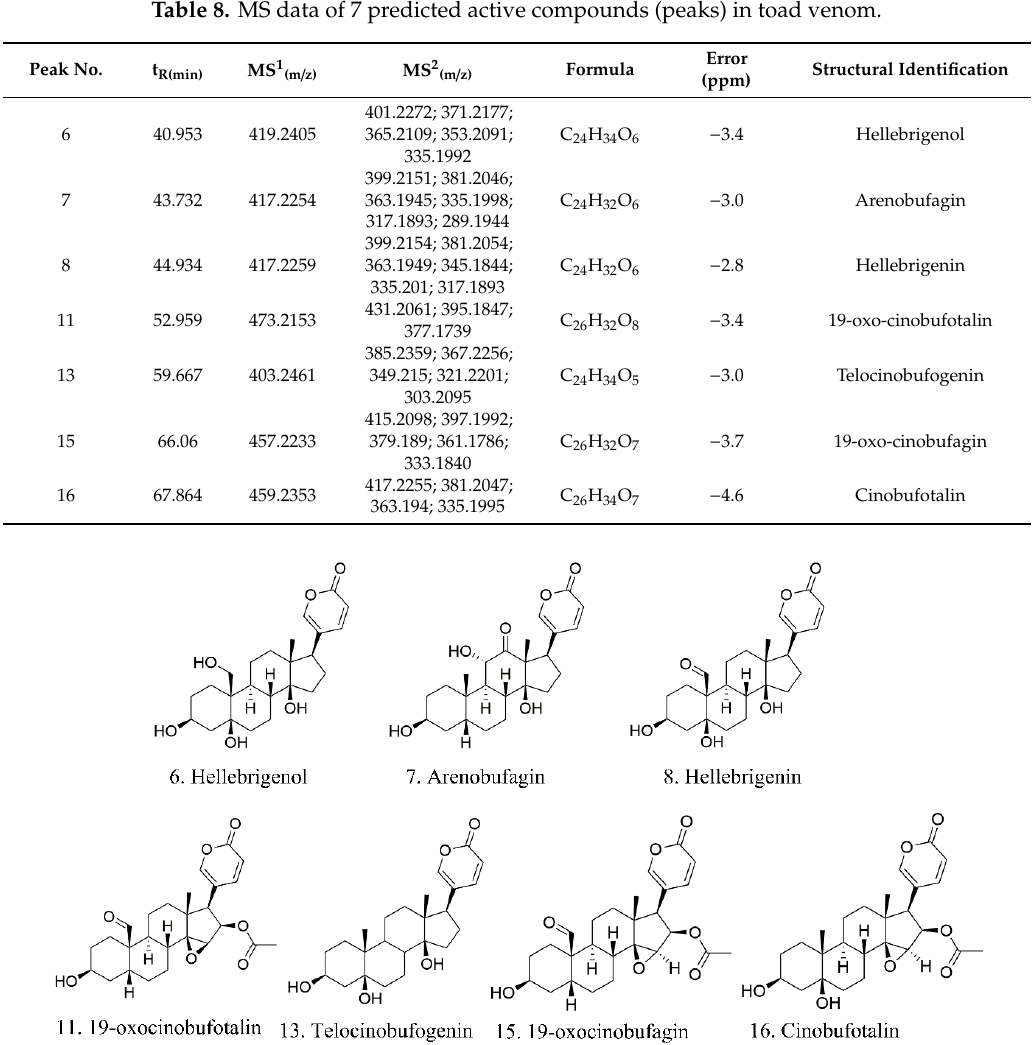
Figure 6. The structure of compounds identified in toad venom extract. Table 8. MS data of 7 predicted active compounds (peaks) in toad venom.